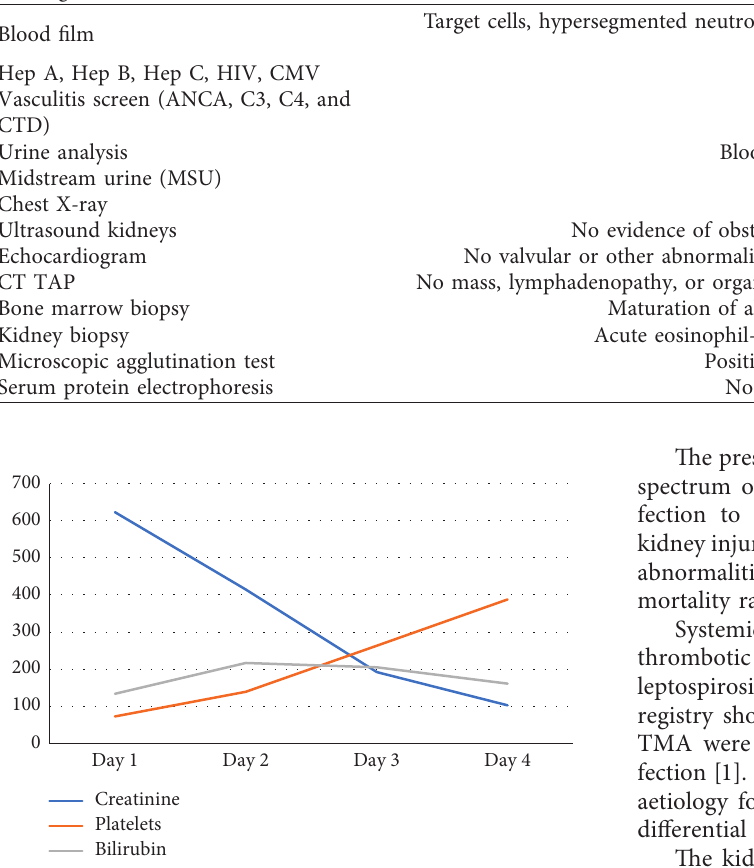
Figure 3: Trends of creatinine, platelets, and